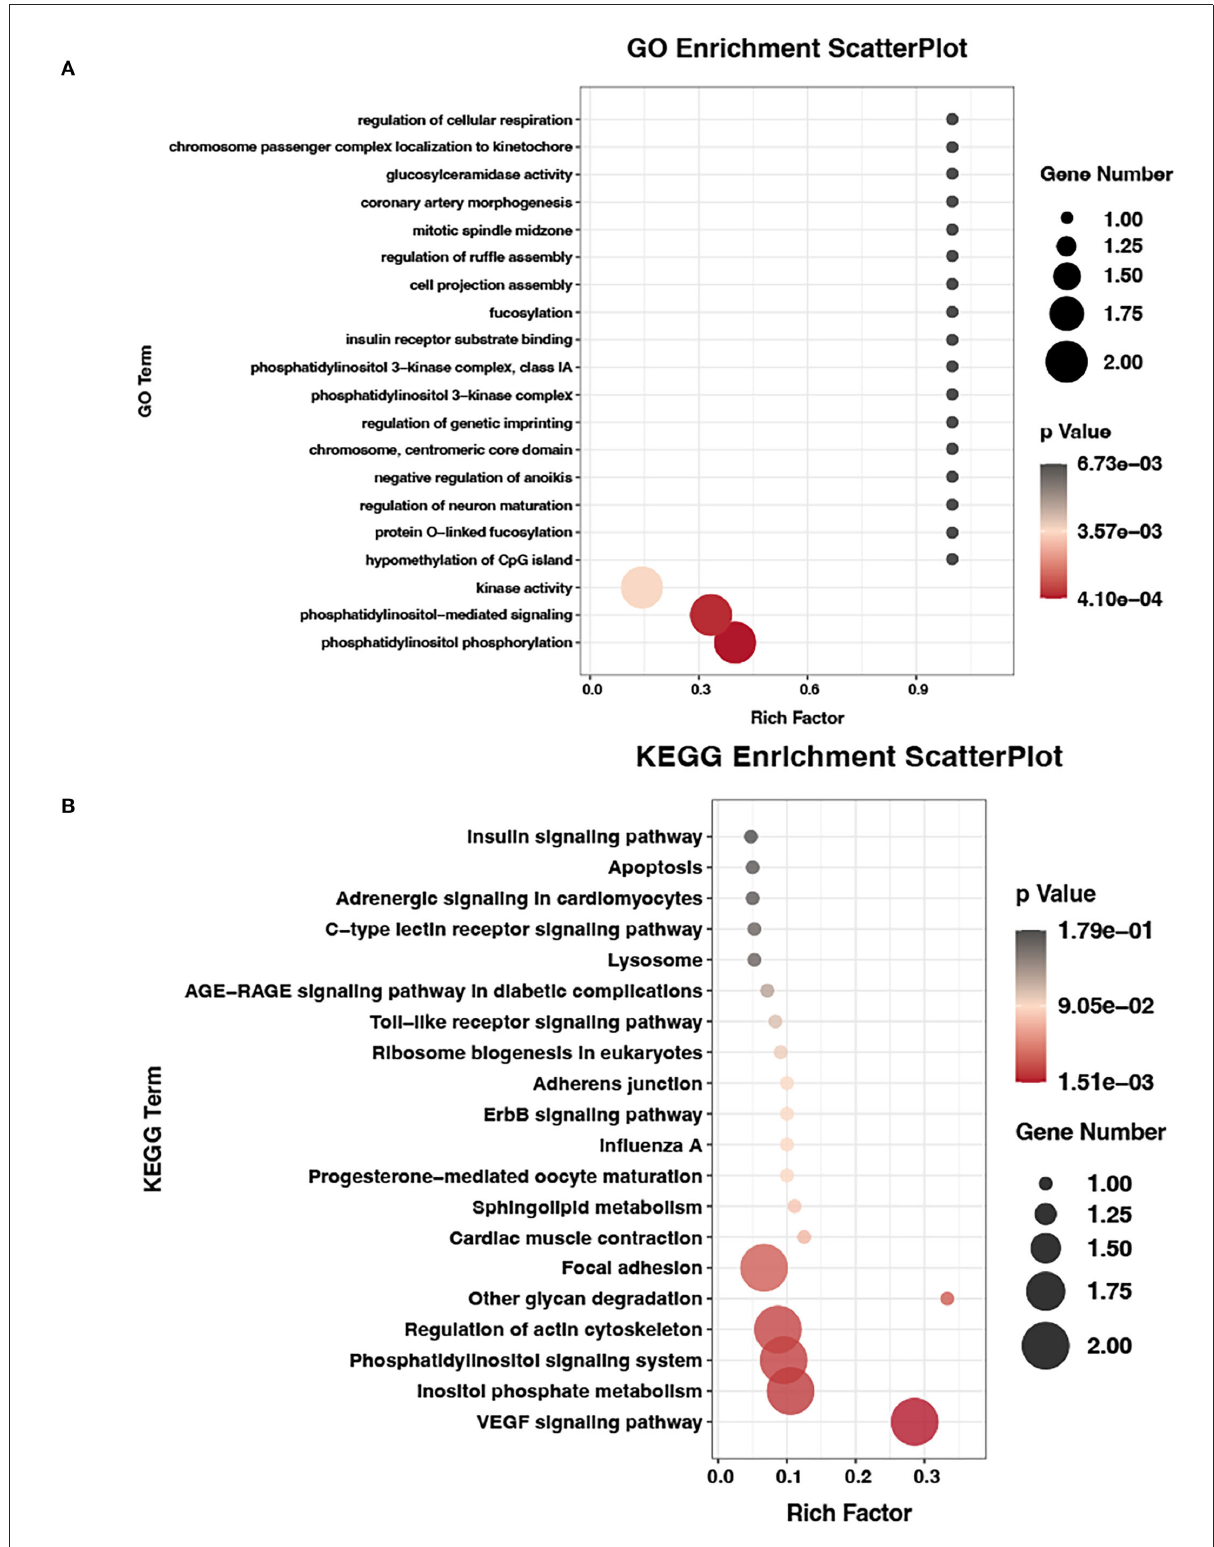
FIGURE6 GO and KEGG analyses of m6A-mRNA-regulated miRNAs data. (A) GO terms of target genes of m6A-mRNA-regulated miRNAs. (B) KEGG enrichment analysis of target genes of m6A-mRNA-regulated miRNAs.